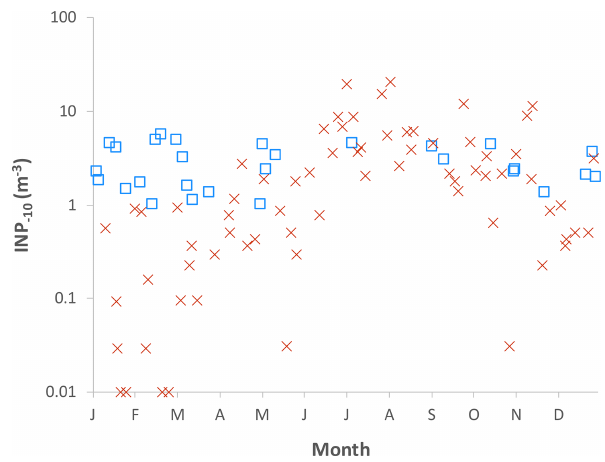
Figure 3. The concentration of INP − 10 when free tropospheric conditions prevailed at Jungfraujoch throughout a full day (open squares) and for days not selected for this criterion (crosses); data are from Conen et al. (2015) (see Table